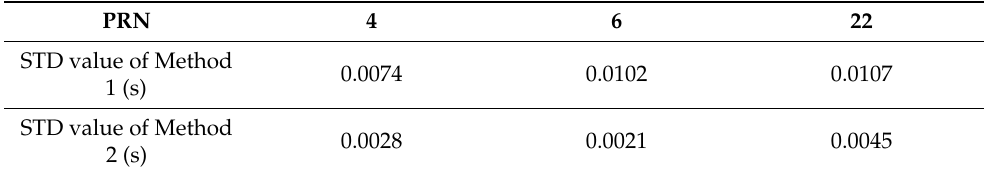
Table 2. STD values of the processing times of selected satellites using the two